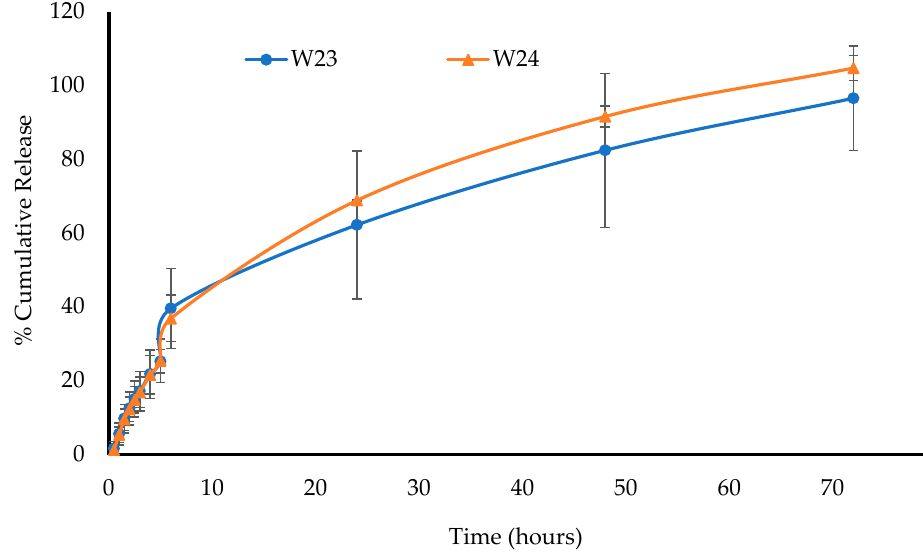
Figure 10. In vitro drug dissolution profiles of MTz (W23 and W24) in SVF at a pH of 4.2 ± 0.1 (mean ± SD, n = 3).